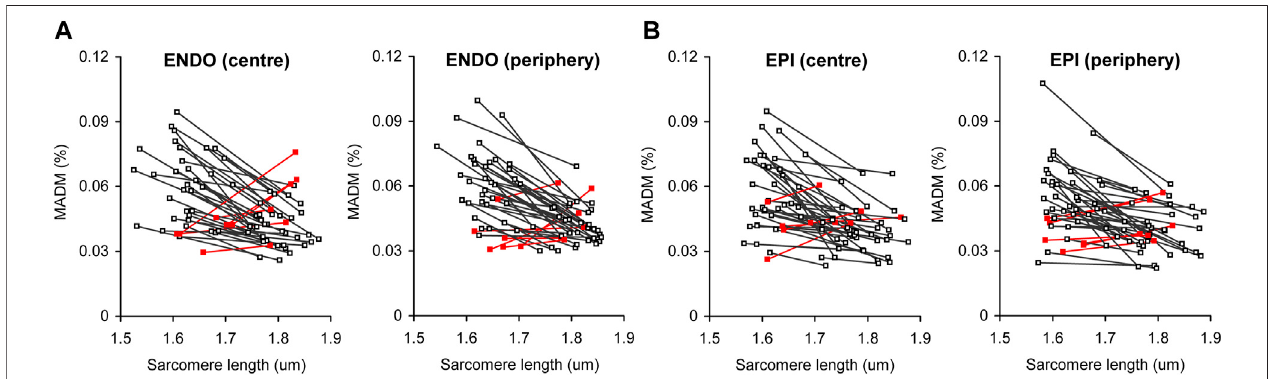
FIGURE 6 | Correlation plots between actual median value of sarcomere length and the extent of sarcomere-to-sarcomere SL variability (evaluated by median absolutedeviationdividedbymedian,MADM)forend-diastole(higherSLvalueforeachindividualline)andend-systole(lowerSLvalueforeachindividualline). (A) Poolof ENDOcellsfromcentralandperipheralintracellularregions( n =40). (B) PoolofEPIcellsfromcentralandperipheralintracellularregions( n =43).Redlinesshowcellswith inverted relationship between median SL value and MADM value [~15% of total number of cells for pooled ENDO and EPI cardiomyocytes (from 8